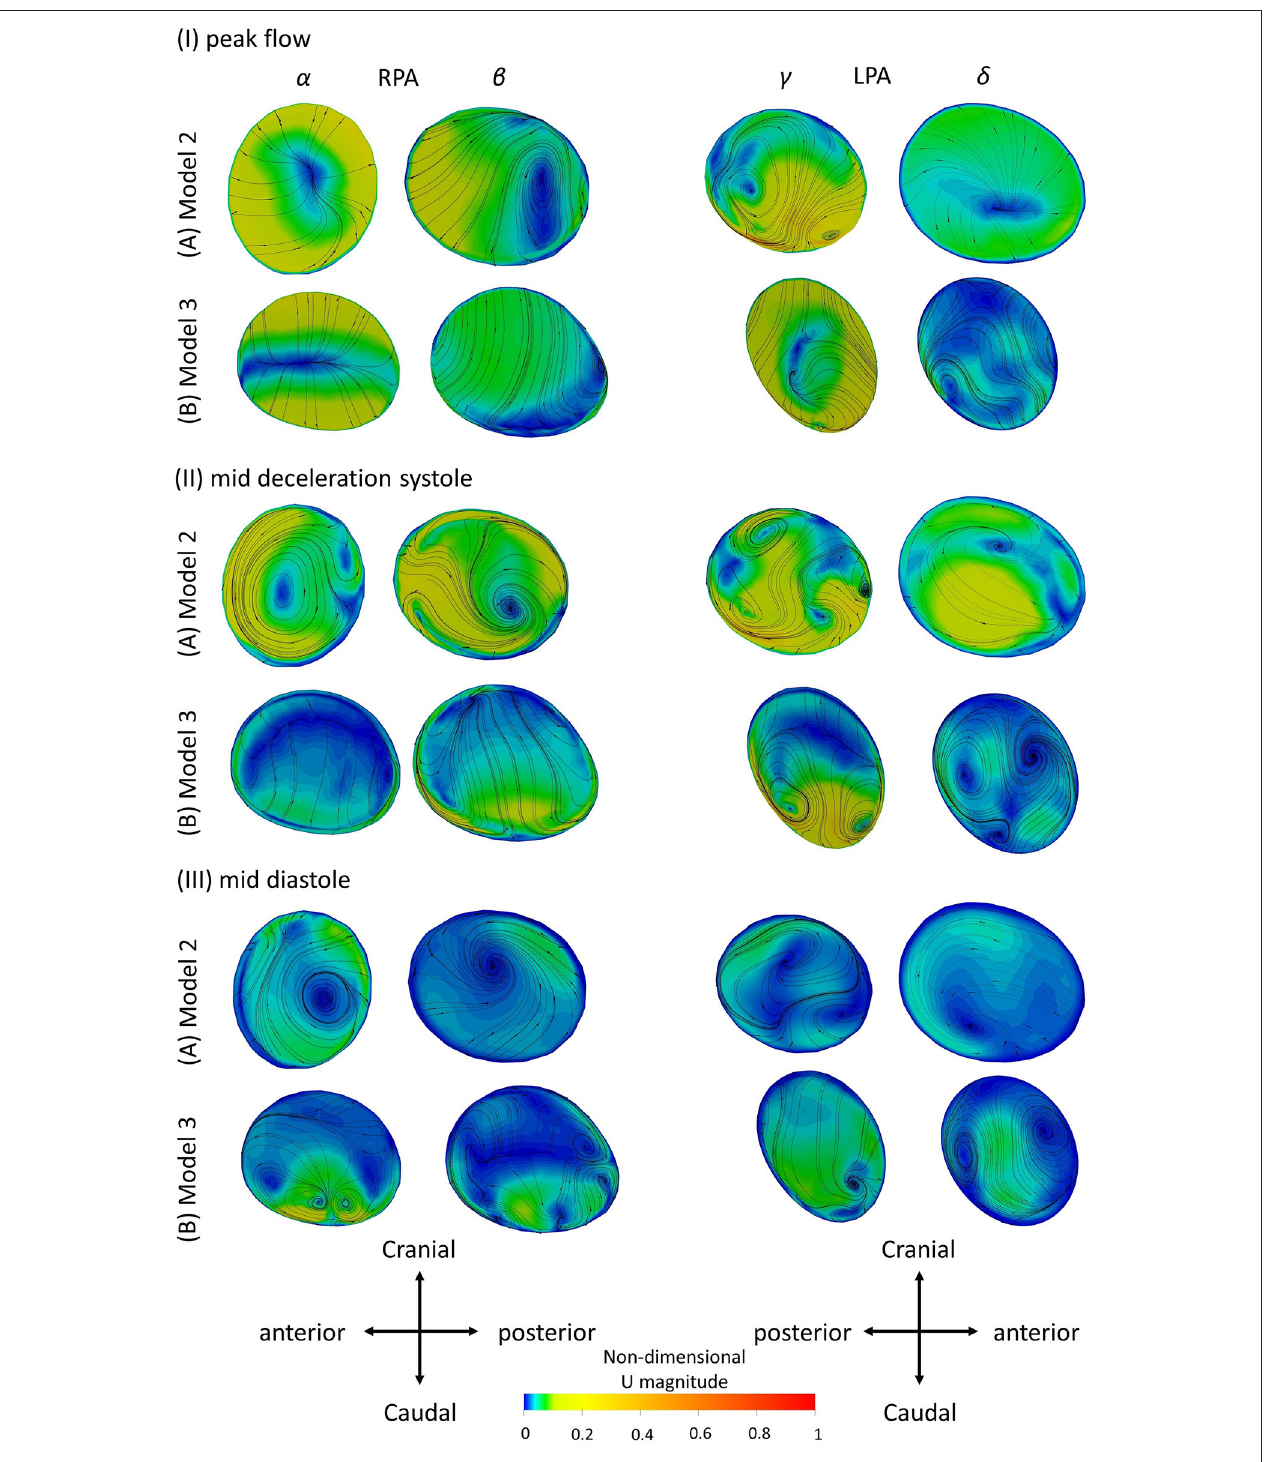
FIGURE 8 | Secondary flow visualized by in plane velocity vectors and contours of normalized velocity normal to the slice during (I) peak flow; (II) mid deceleration at systole; and (III) mid diastole, for (A) Model 2; and (B) Model 3. Non-dimensionalization was performed by division with the maximum velocity of each patient during the cardiac cycle. Points where slices ( α ) to ( δ ) are taken are visible in Figure 1B . Cross-sections are oriented with the top and the bottom edges corresponding to the cranial and caudal positions, respectively and left and right to the anterior and posterior of the pulmonary artery, for the RPA, and to the posterior and anterior of the pulmonary artery, for the LPA, respectively. Cross-sections are in